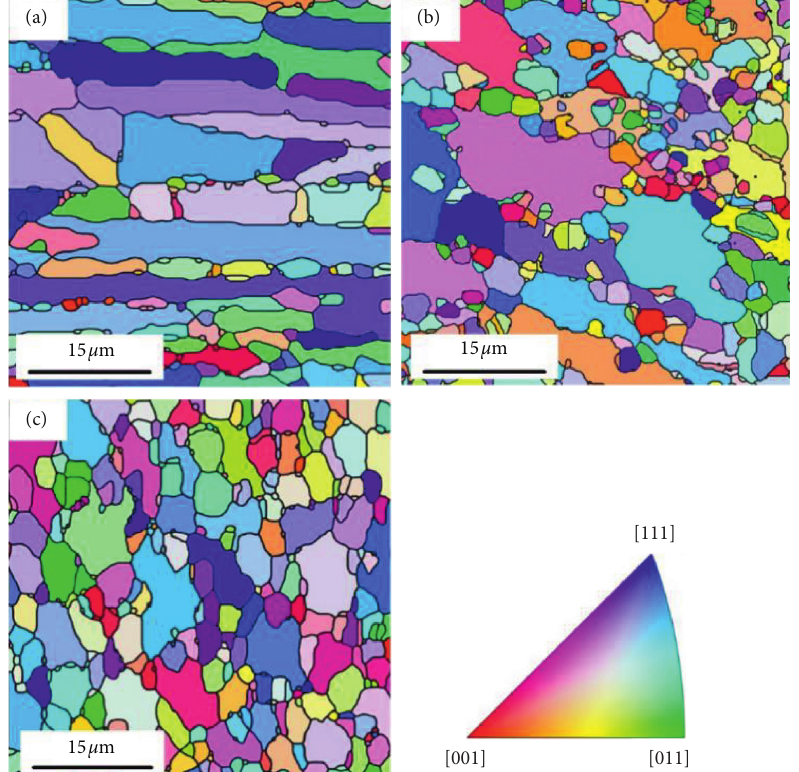
Figure 3: Grain morphologies in (a) base material, (b) stir zone obtained at 30mm/min, and (c) stir zone obtained at